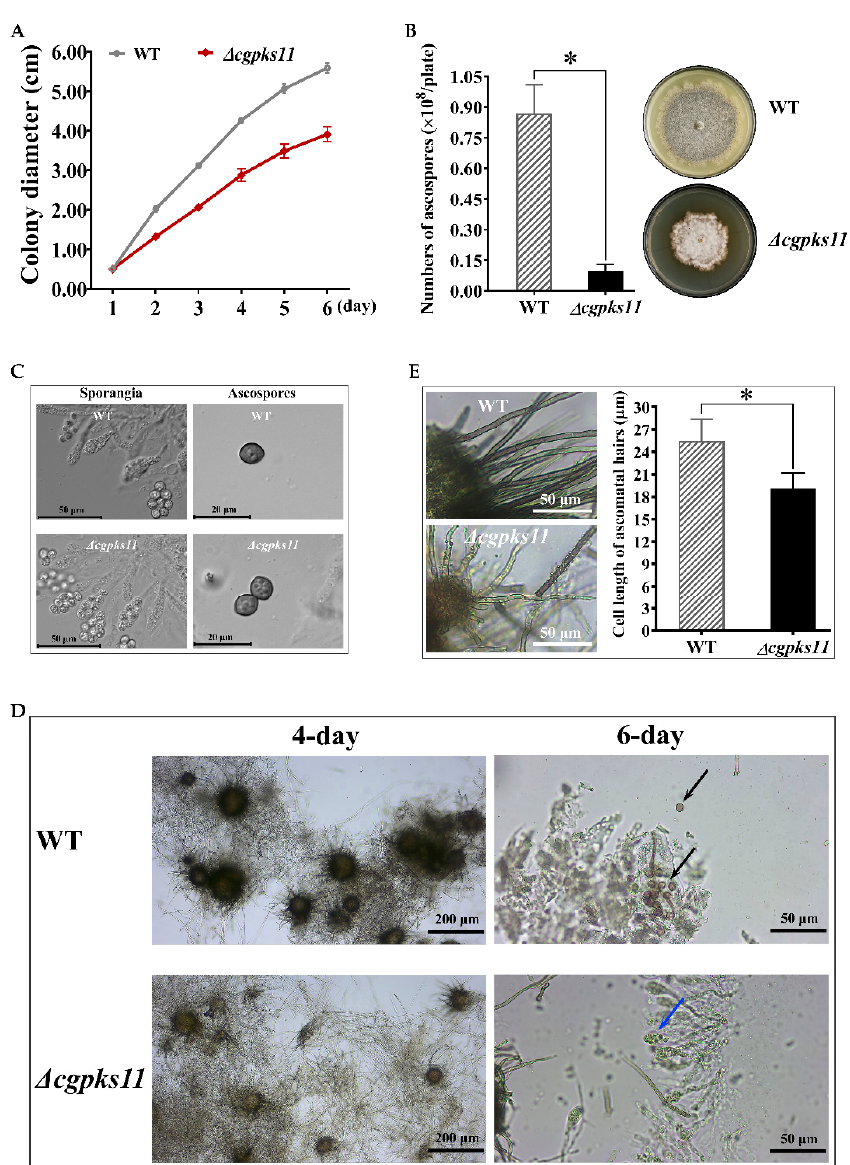
Figure 5. CgPKS11 deletion led to decelerated growth and delayed sporulation. ( A ) The growth curve of WT and ∆ cgpks11 strains when cultivated in PDA plates. The ∆ cgpks11 mutant was inoculated in PDA plate supplemented with 100 µ g/mL hygromycin B. ( B ) Comparison of ∆ cgpks11 with WT on colony morphology and sporulation ability. ( C ) Morphology characteristics of sporangia and ascospores produced from WT and ∆ cgpks11 mutant. ( D ) Maturation of ascospores in WT and ∆ cgpks11 strains. Left (ascocarps), under the 10 × objective lens; right, the black and blue arrow indicated the mature ascospores and immature ascospores in sporangium under the 40 × objective lens, respectively. ( E ) Cell length of ascoma hairs from WT and ∆ cgpks11 strains was observed and measured under the microscope by using the 40 × objective lens. There is significantly difference between the mutant and WT as indicated by an asterisk ( p -value < 0.01 with t -test